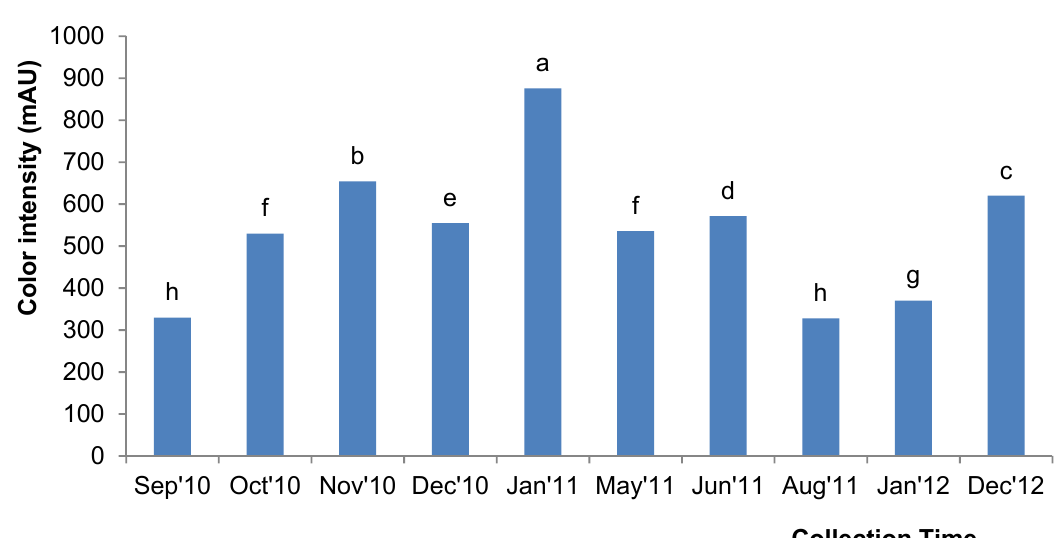
Figure 3. Color intensity of the Malaysian acacia honeys. Values with different letters indicate significant differences ( p <